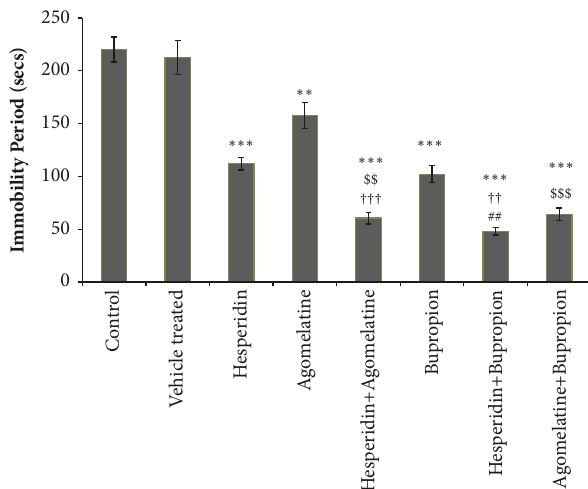
Figure 2: Tail suspension test. Significant difference is denoted by ∗ ∗ ∗ P < 0.001 and ∗∗ P < 0.01 as compared to control group; $$$ P < 0.01and$$P < 0.01ascomparedtoagomelatinetreatedgroup; ††† P < 0.001 and †† P < 0.01 as compared to hesperidin treated group; ## P < 0.01 as compared to bupropion treated